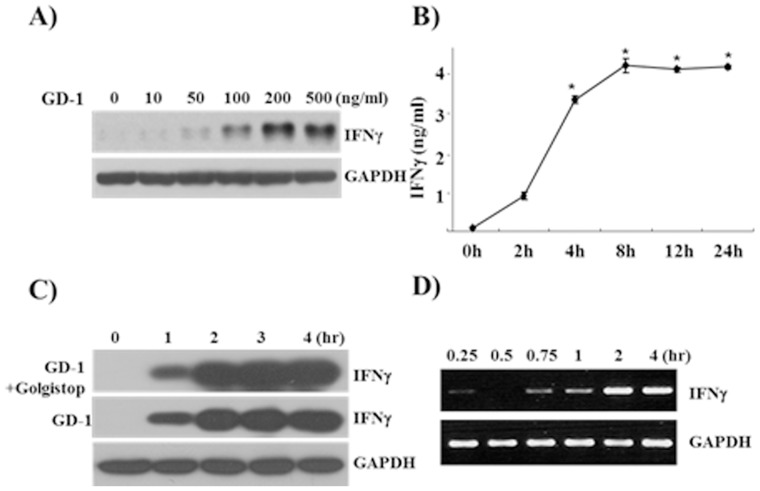
GD-1 regulates the transcription of IFN-γ.
A. The effect of GD-1 on IFN-γ production was analyzed by Western blotting of the culture medium after GD-1 treatment at various concentrations (0∼200 ng/ml). The production of IFN-γ increased with the increase of GD-1 concentration. B. The time-dependent increase of IFN-γ secretion was analyzed by ELISA, which showed the production of IFN-γ reached plateau around 3-hr treatment of GD-1. Triplicate samples in each time were tested and averaged. Error bars indicate standard deviation. All ELISA data are representative of at least three independent experiments. *P<0.05. C. The production of IFN-γ was increased in a time-dependent manner. 100 ng/ml of GD-1 was treated onto NK-92 cells, and the culture supernatant was taken at various time points for Western blot analysis. IFN-γ production was seemed to begin within 1 hr. Golgistop treatment has showed that GD-1 does not affect the secretory pathway for IFN-γ production. D. Time dependent transcriptional activity for IFN-γ in NK-92 cell after GD-1 treatment was evaluated by RT-PCR. The transcription of IFN-γ was increased within 1 hr after GD-1 treatment.